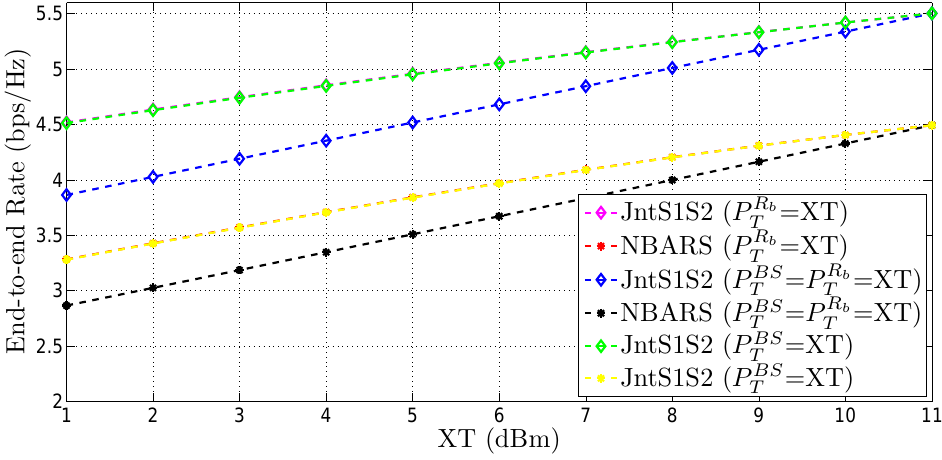
Figure 2. Throughput (bps/Hz) versus total power